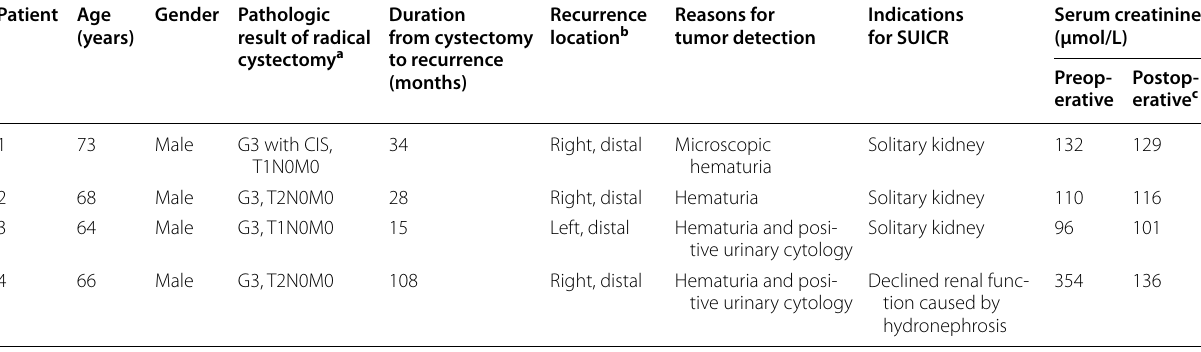
Table 1 Clinical features of four patients with distal upper urinary tract recurrence of bladder cancer following cystec-